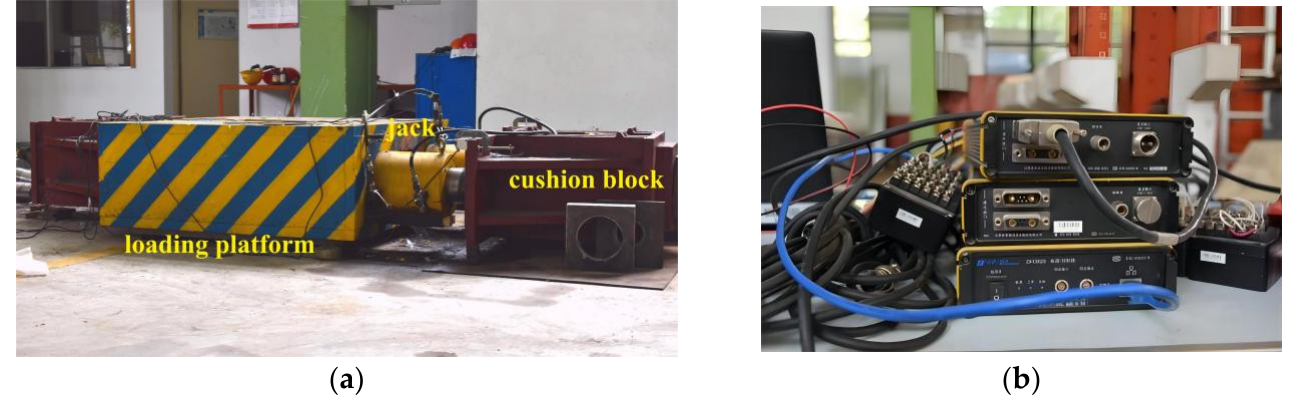
Figure 5. Loading device of static tensile test: ( a ) loading platform, jack; ( b ) strain test acquisition system.